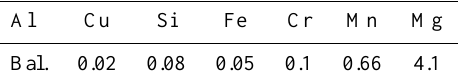
Table 2. Chemical Composition of Al5083 (wt%).